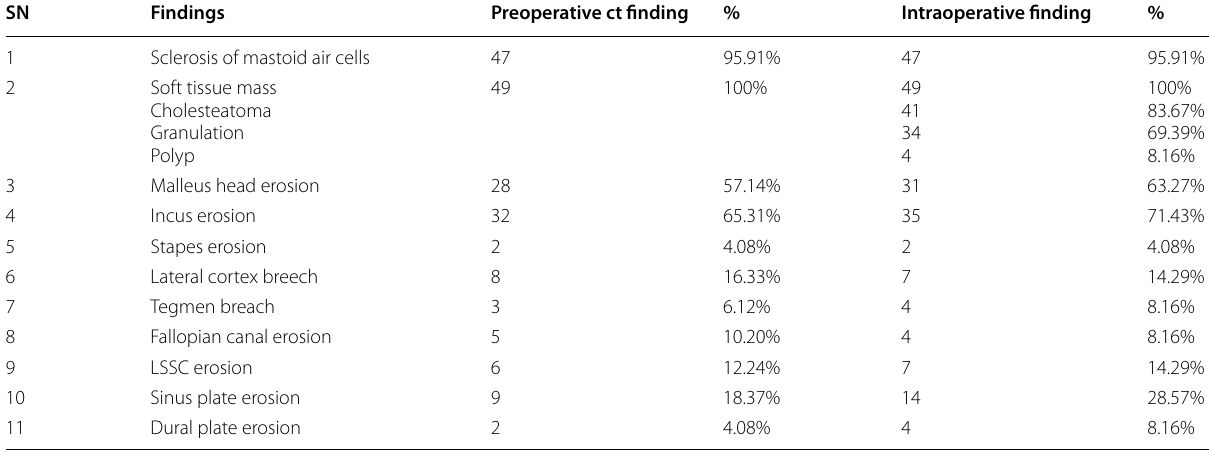
Table 3 Comparison between preoperative CT findings and intraoperative findings